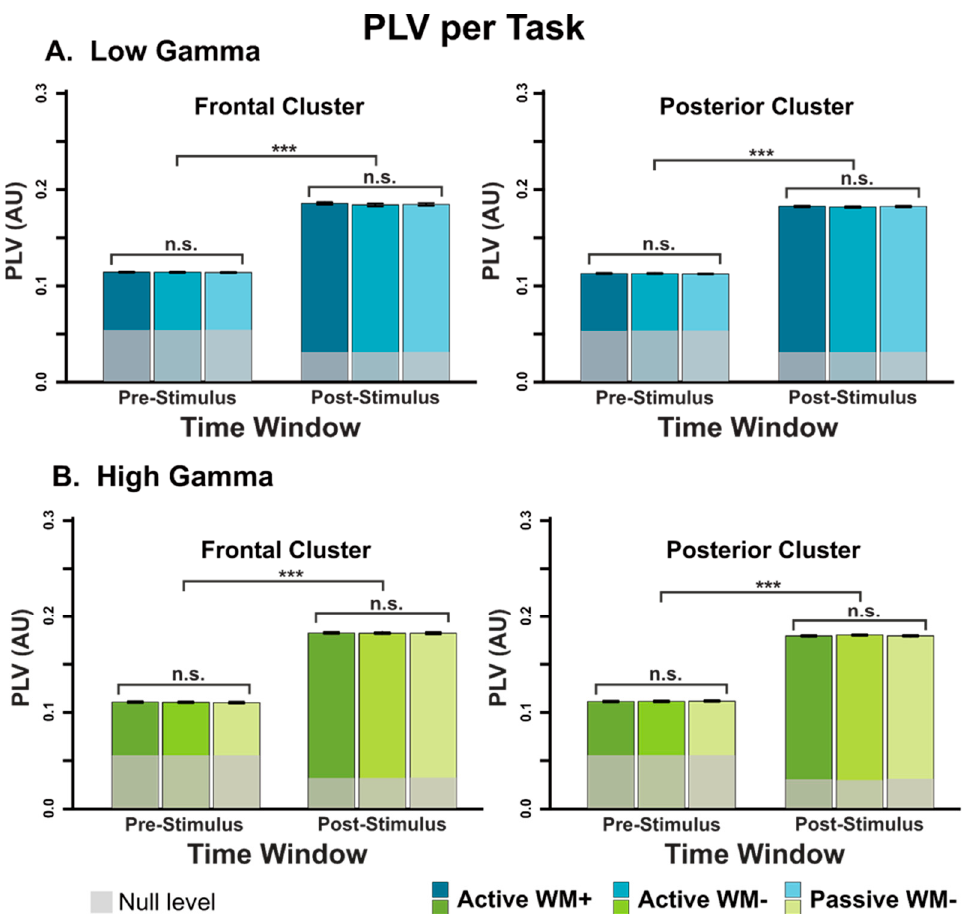
Figure 4. Average PLV per task across the different clusters and frequency bands. The shaded areas on each bar represent the PLV of the null permutations and mark the PLV one would expect by chance. When marking significance, *** denotes p < 0.001.